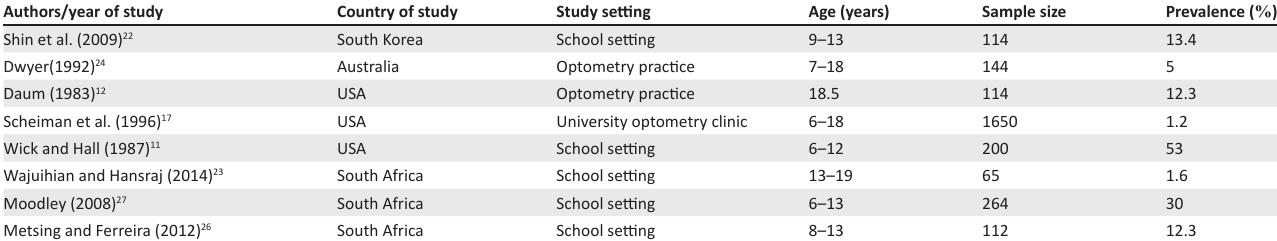
TABLE 4: Summary of studies on accommodative infacility. Authors/year of study